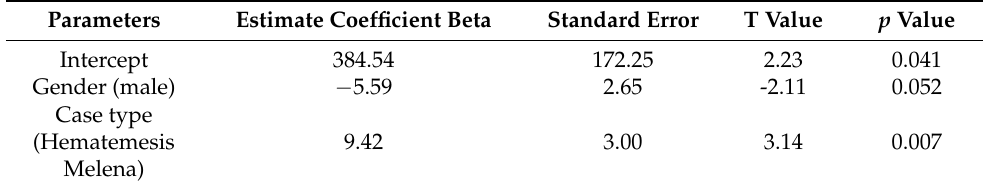
Table 3. Regression Coefficient.